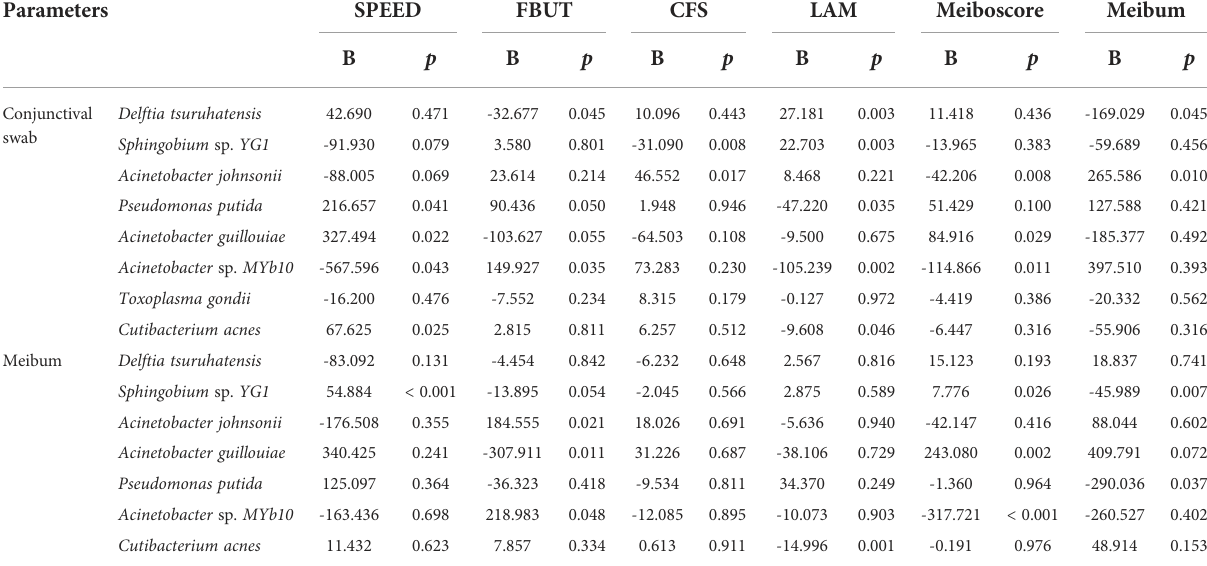
TABLE 5 Associations of ocular surface parameters and the species (RA>2.0%) in the conjunctival swab and meibum samples using generalized estimating equations analysis.